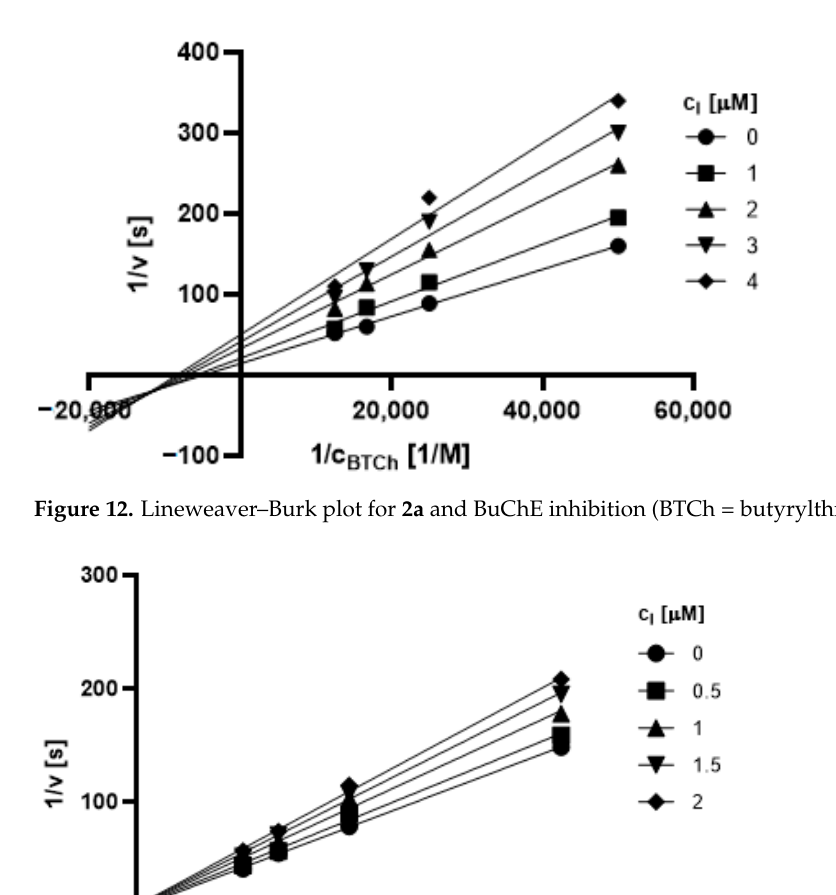
Figure 11. Lineweaver–Burk plot for 2a and AChE inhibition (ATCh = acetylthiocholine).